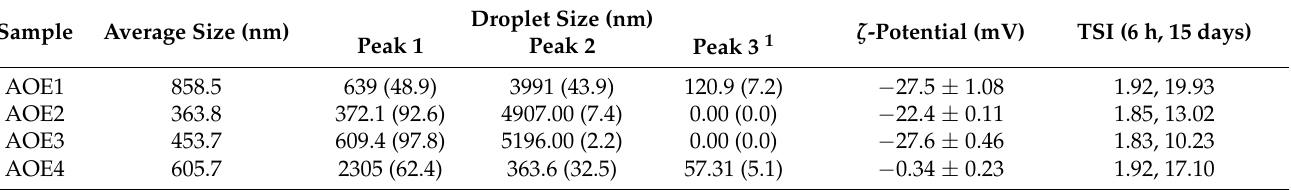
Table 2. Influence of mixed particle/emulsifier on stability and physical characteristics of emulsions